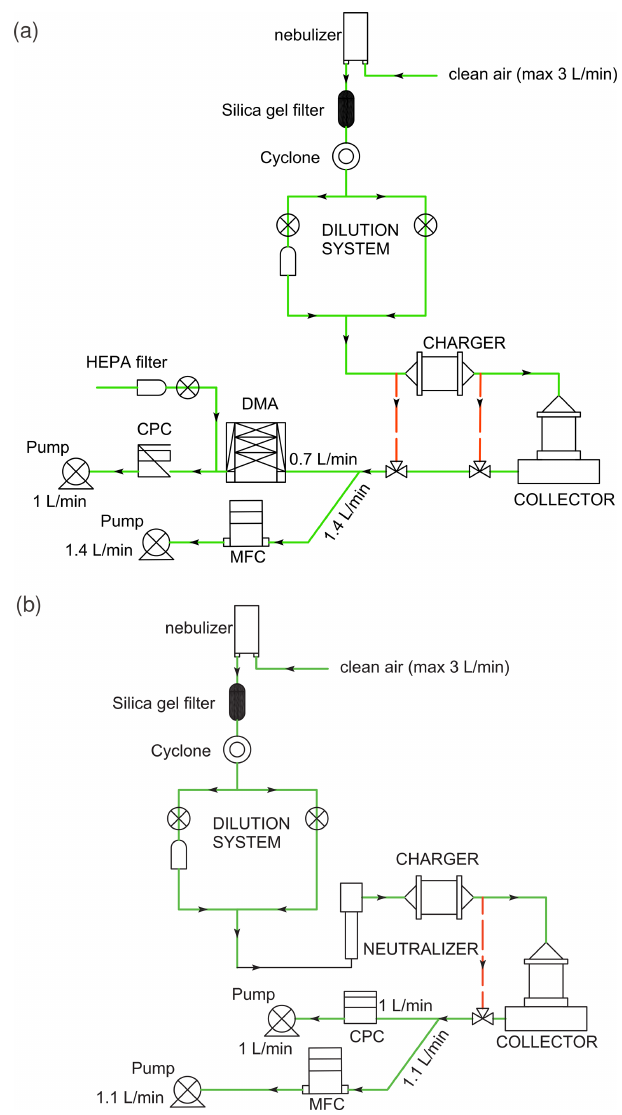
Figure 2. Diagram of the aerosol flow system experiments (the green line is the main flow line, and the red dotted lines are the alternate bypass lines) for (a) obtaining the particle size distribu- tion and (b) obtaining the mass loading reference through the CPC particle